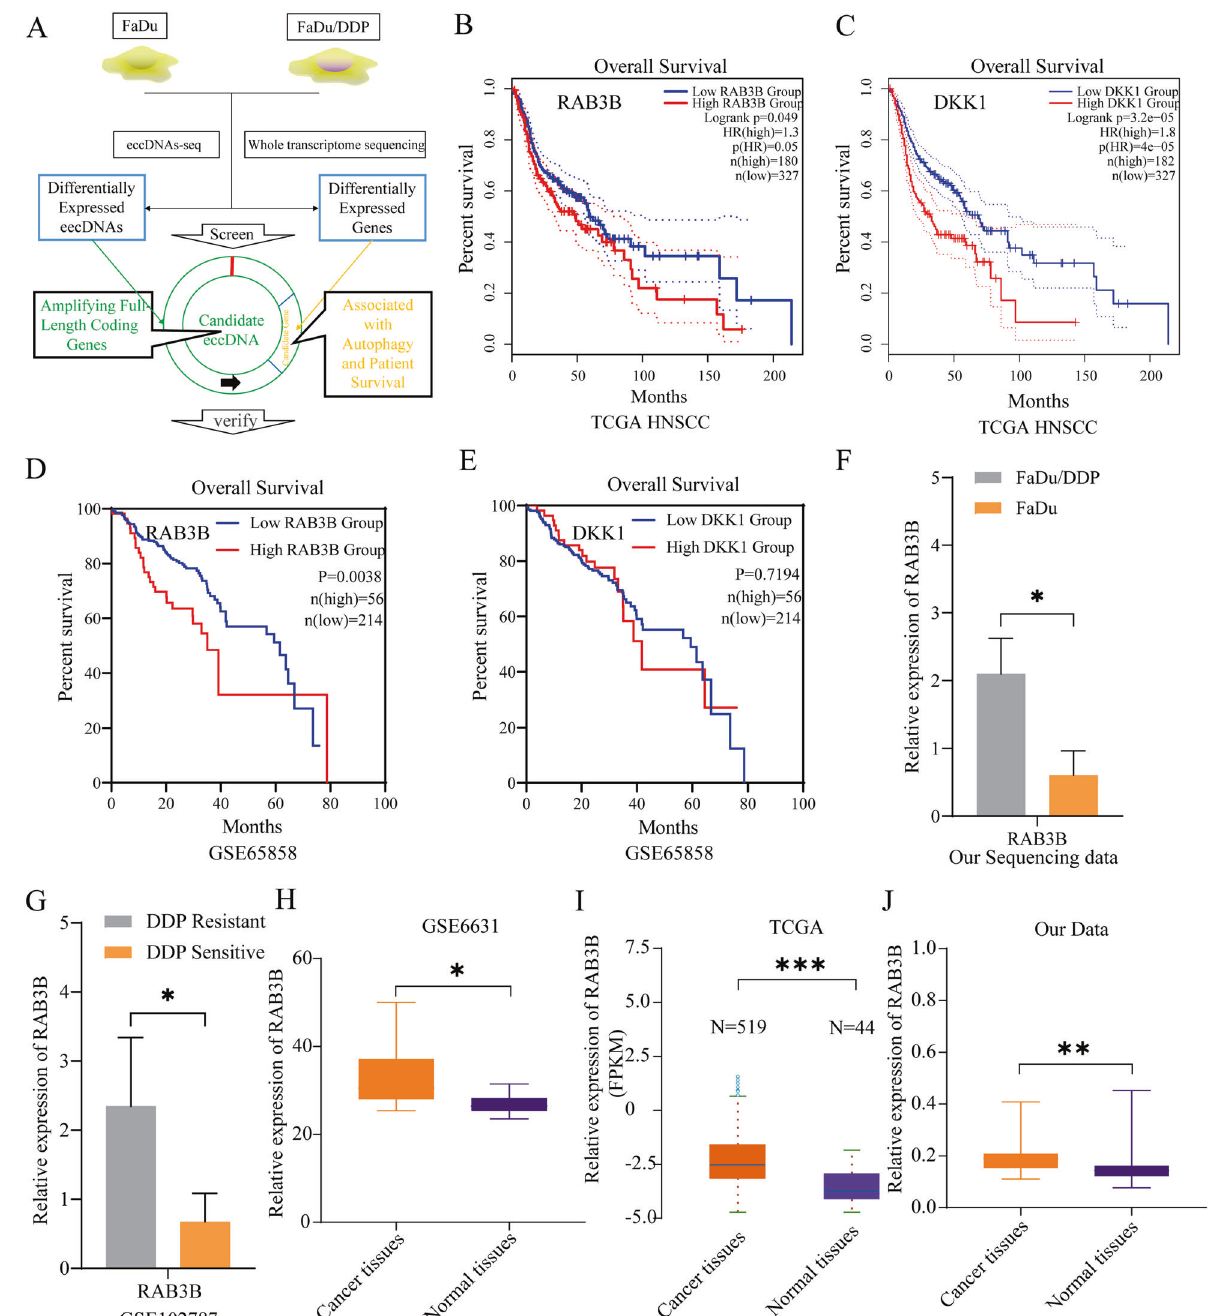
Fig. 4 Flowchart of screening out the candidate gene RAB3B followed by further validation based on TCGA and GEO databases. A Flowchart of candidate gene for further study. Kaplan – Meier analysis of the OS rate in HNSCC patients in the TCGA database with high or low expression of RAB3B ( B ) and DKK1 ( C ). Kaplan – Meier analysis of the OS rate in HNSCC patients in the GSE658658 database with high or low expression of RAB3B ( D ) and DKK1 ( E ). F Relative mRNA expression ( z scores) of RAB3B between FaDu/DDP cells and FaDu cells in